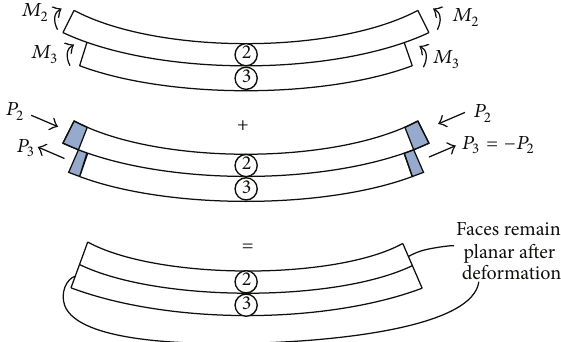
Figure 2: The faces of the delamination remain planar after deformation, adapted from